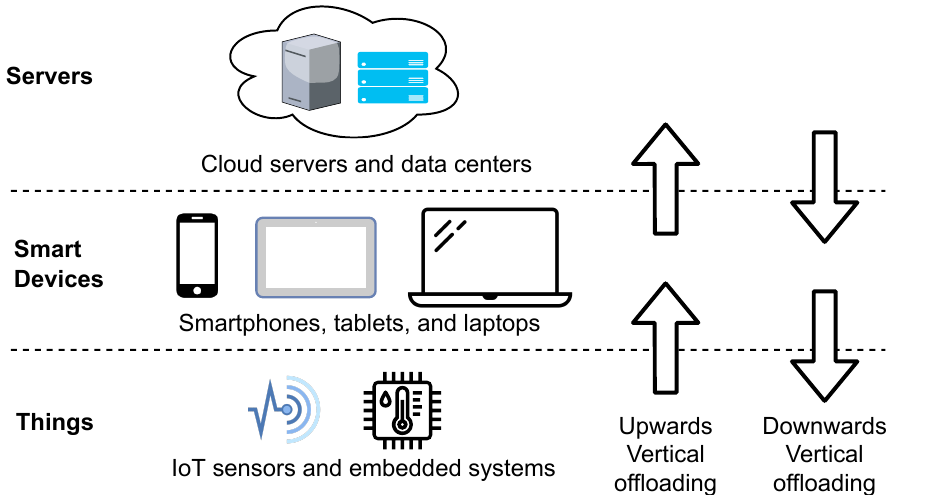
Figure 1. A three-layer architecture model [30], which consists of servers, smart devices, and